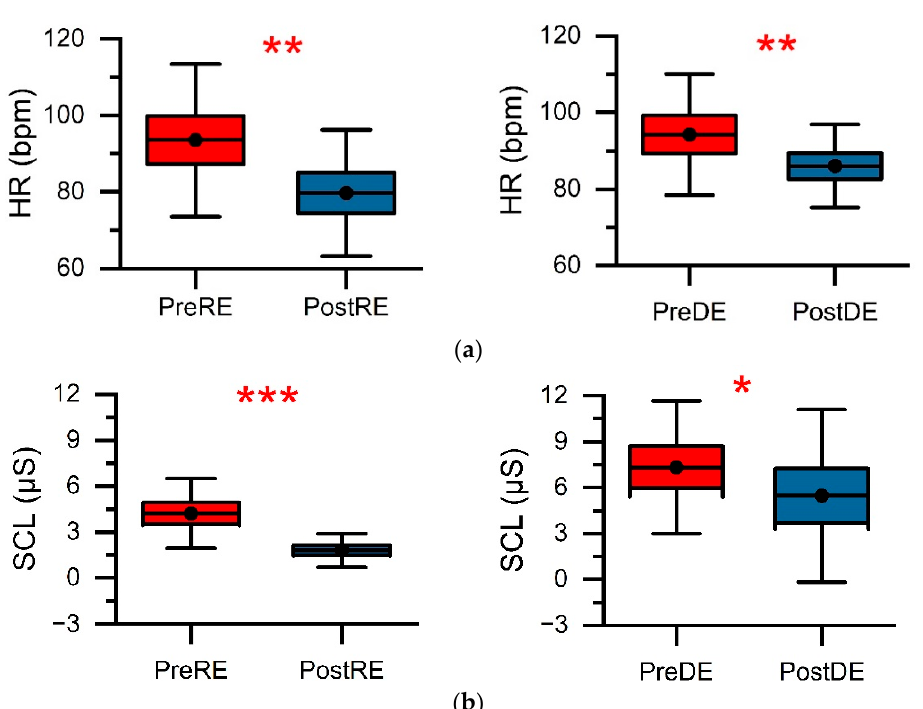
Figure 5. Average values of ( a ) HR and ( b ) for pre- and post-test of ( left ) RE and ( right ) DE. The error bars indicate the SD, and the red stars indicate significant differences (* p < 0.05, ** p < 0.01, and *** p < 0.001).